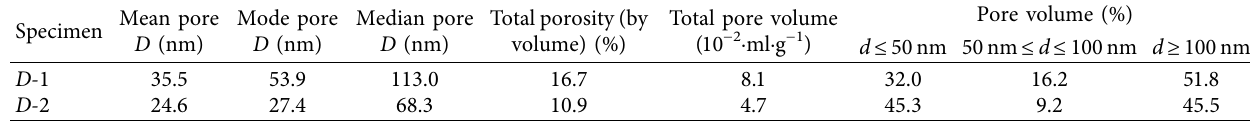
Table 9: Pore size distributions of concrete specimens in IFT and MFT environments. Mean pore Specimen D